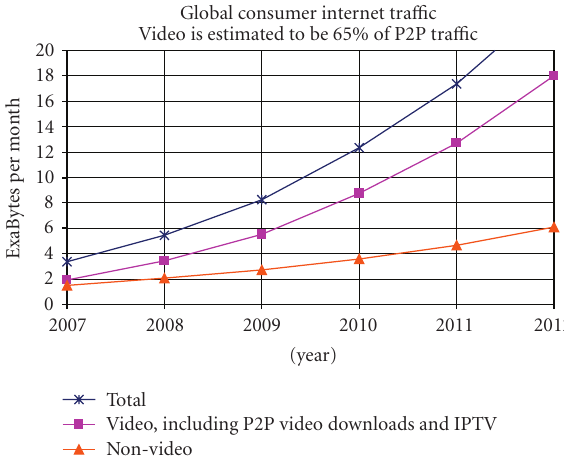
Figure 10: Aggregated Cisco projections for global consumer Internet growth: Video is projected to grow to be almost 75% of total consumer broadband tra ffi c.